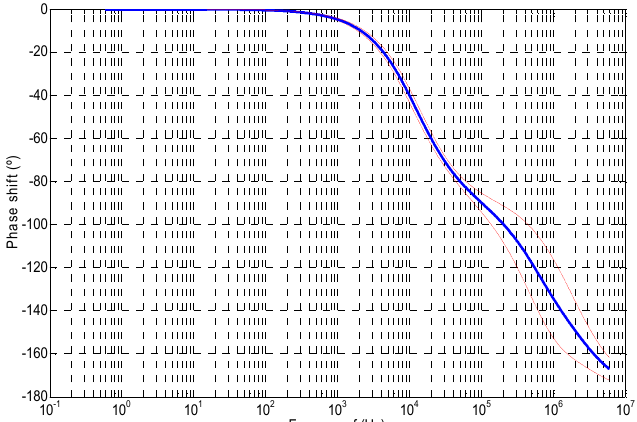
Figure 3. Phase shift ϕ (º) vs. frequency f